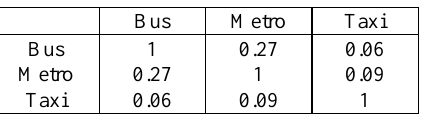
Table 3. Spatial correlation coefficients